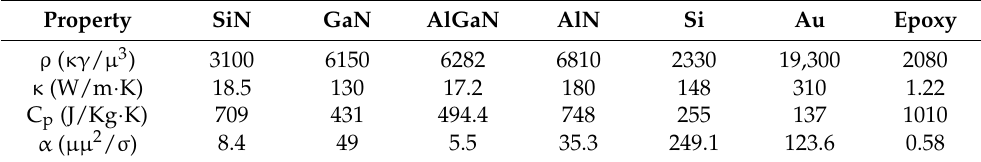
Table 1. Material constants used in the simulation for the temperature of 300 K are listed below.